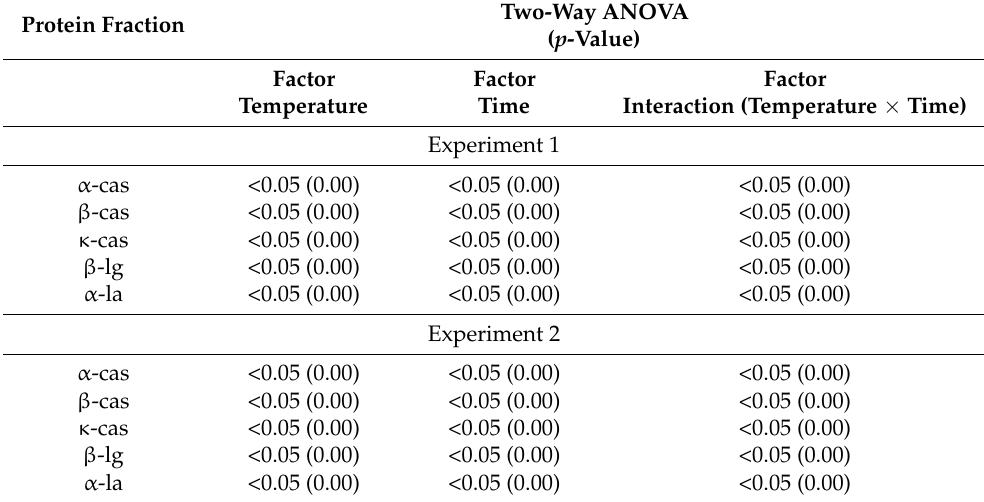
Table 3. Results of two-way ANOVA.